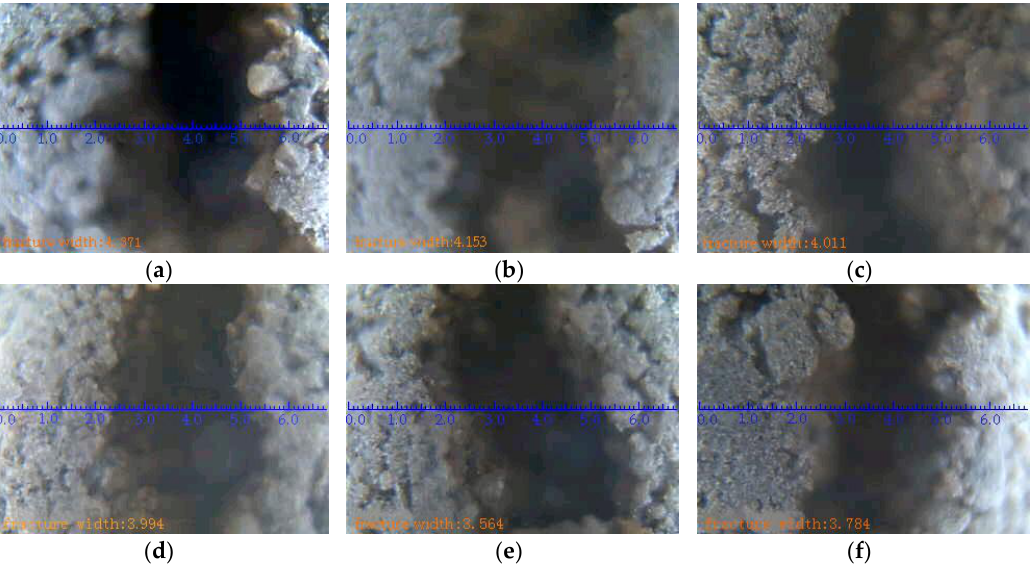
Figure 14. GSF ③ evolution vs. CPMD: ( a ) Aligned pillars; ( b ) CPMD of 10 m; ( c ) CPMD of 30 m;